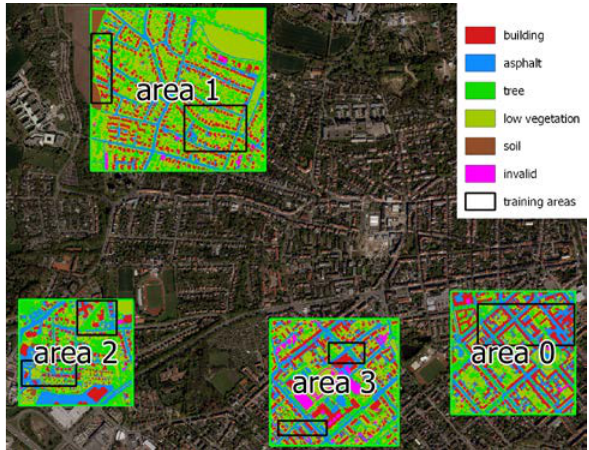
Figure 1. The test data and the labelled areas (areas 0-3). Pixels inside the black rectangles are training samples